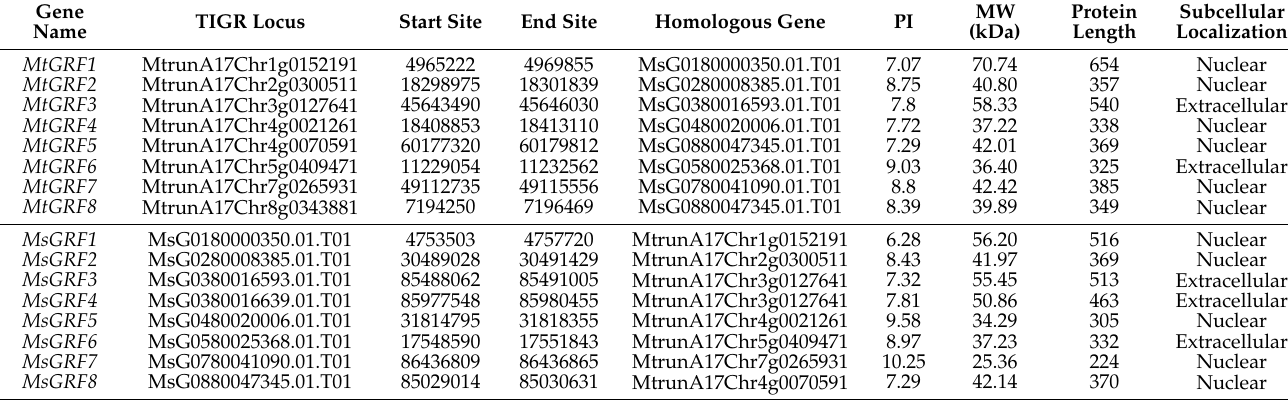
Table 1. Properties of the predicted GRF proteins in M. truncatula and M. sativa